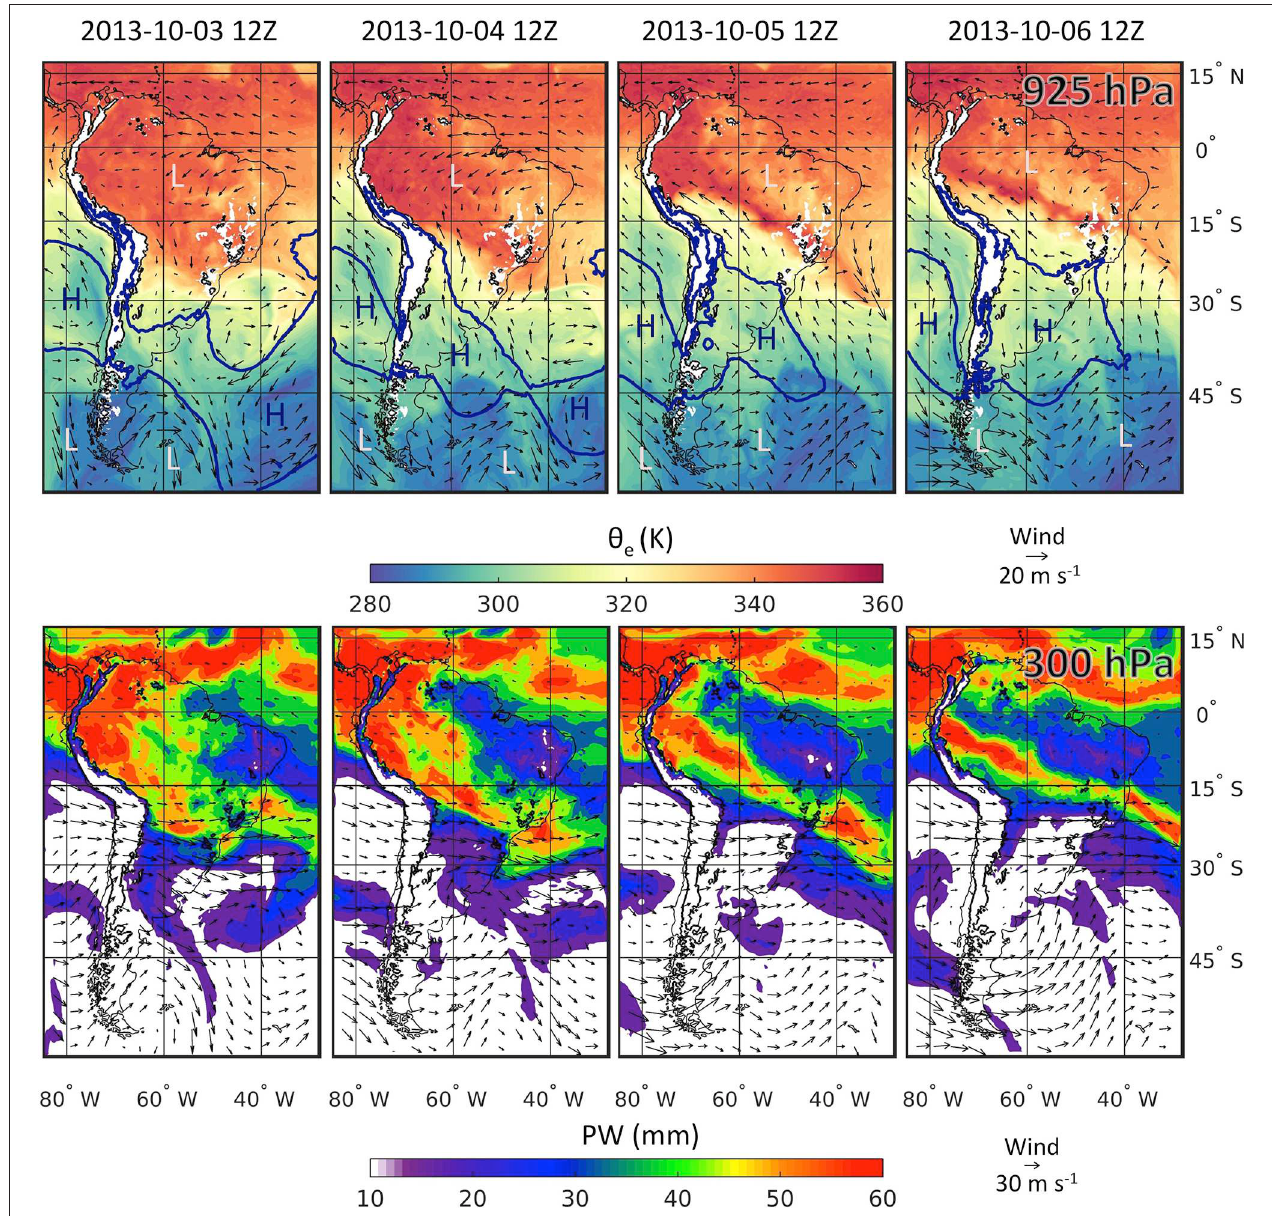
FIGURE 5 | WRF simulation ( D 01, 18 km ) of the CAI event on October 3–7, 2013. Top row shows the equivalent potential temperature and 925 hPa level horizontal wind fields. The blue contour line delineates the 1,020 hPa sea level pressure. Areas of high and low pressure are marked with H and L, respectively. Bottom row shows the Precipitable Water (PW) overlain on the 300 hPa level horizontal wind fields. A movie showing the temporal evolution of PW during the event duration is available as Supplemental Information S2 .